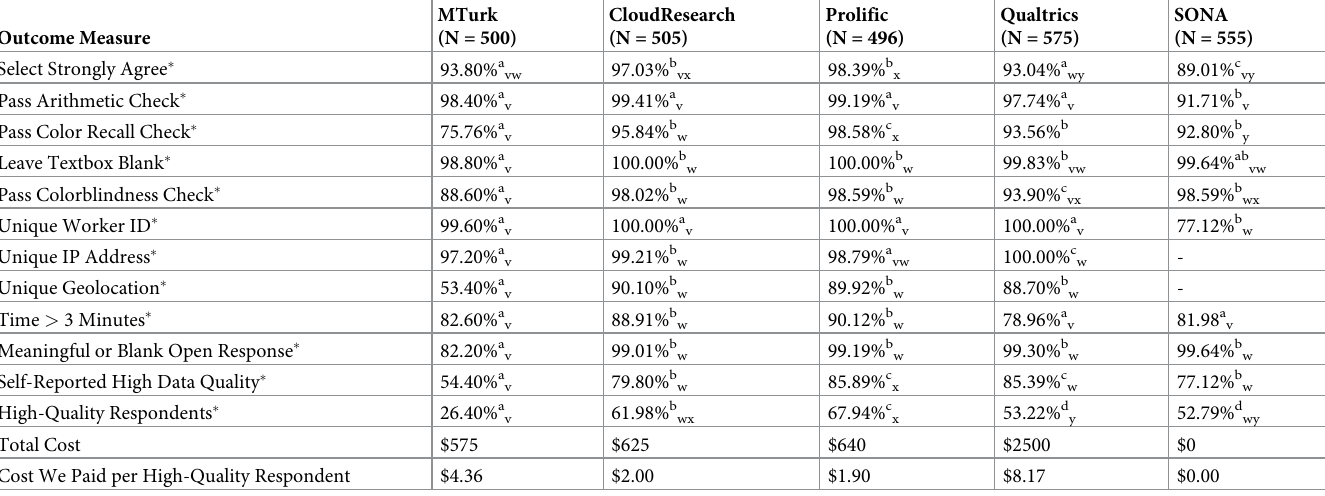
Table 2. Percent of participants with high-quality data for the dichotomous outcome measures, and the cost we paid per high-quality respondent broken down by platform. "High-Quality Respondents" are Those Who Passed 4 or More Attention Checks (rows 1–5) and the Other Criteria Reported (rows